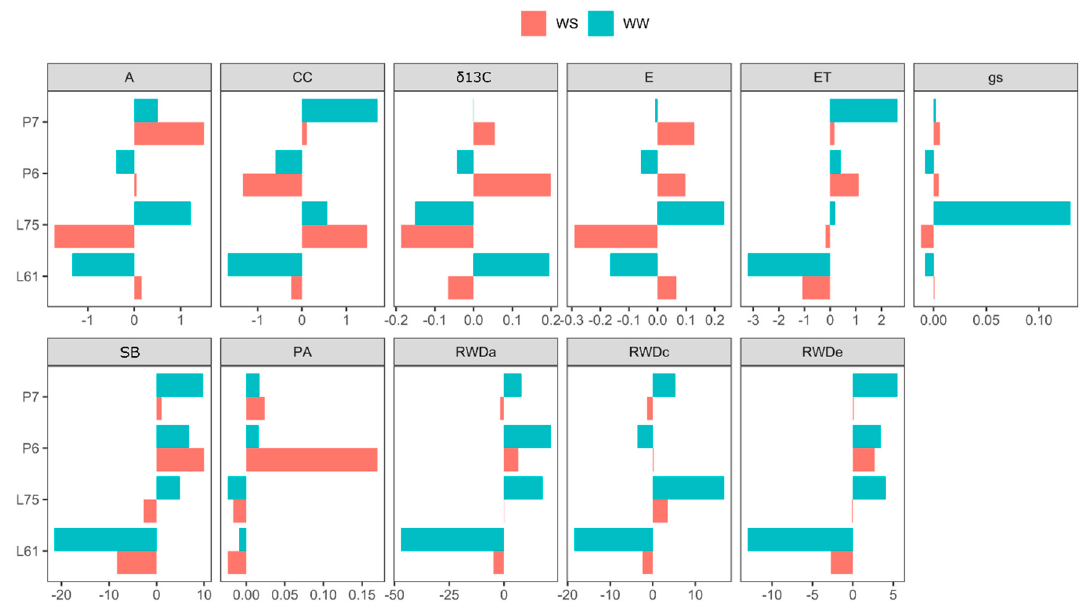
Figure 3. Estimates of the effects of general combining ability (GCA) on morphological traits, water status, and root traits in popcorn lines under water stress (WS) and well-watered (WW) conditions. WS: water stress; WW: well-watered; SB: shoot biomass; PA: whole plant area; CC: chlorophyll concentration (Dualex index); δ 13 C: carbon isotope discrimination; A: net CO 2 assimilation rate; g s : stomatal conductance; E: transpiration; ET: cumulative plant transpiration; RWD a : root weight density of the section a (0–30 cm); RWD c : root weight density of the section c (60–90 cm); RWD e : root weight density of the section e (120–150 cm).